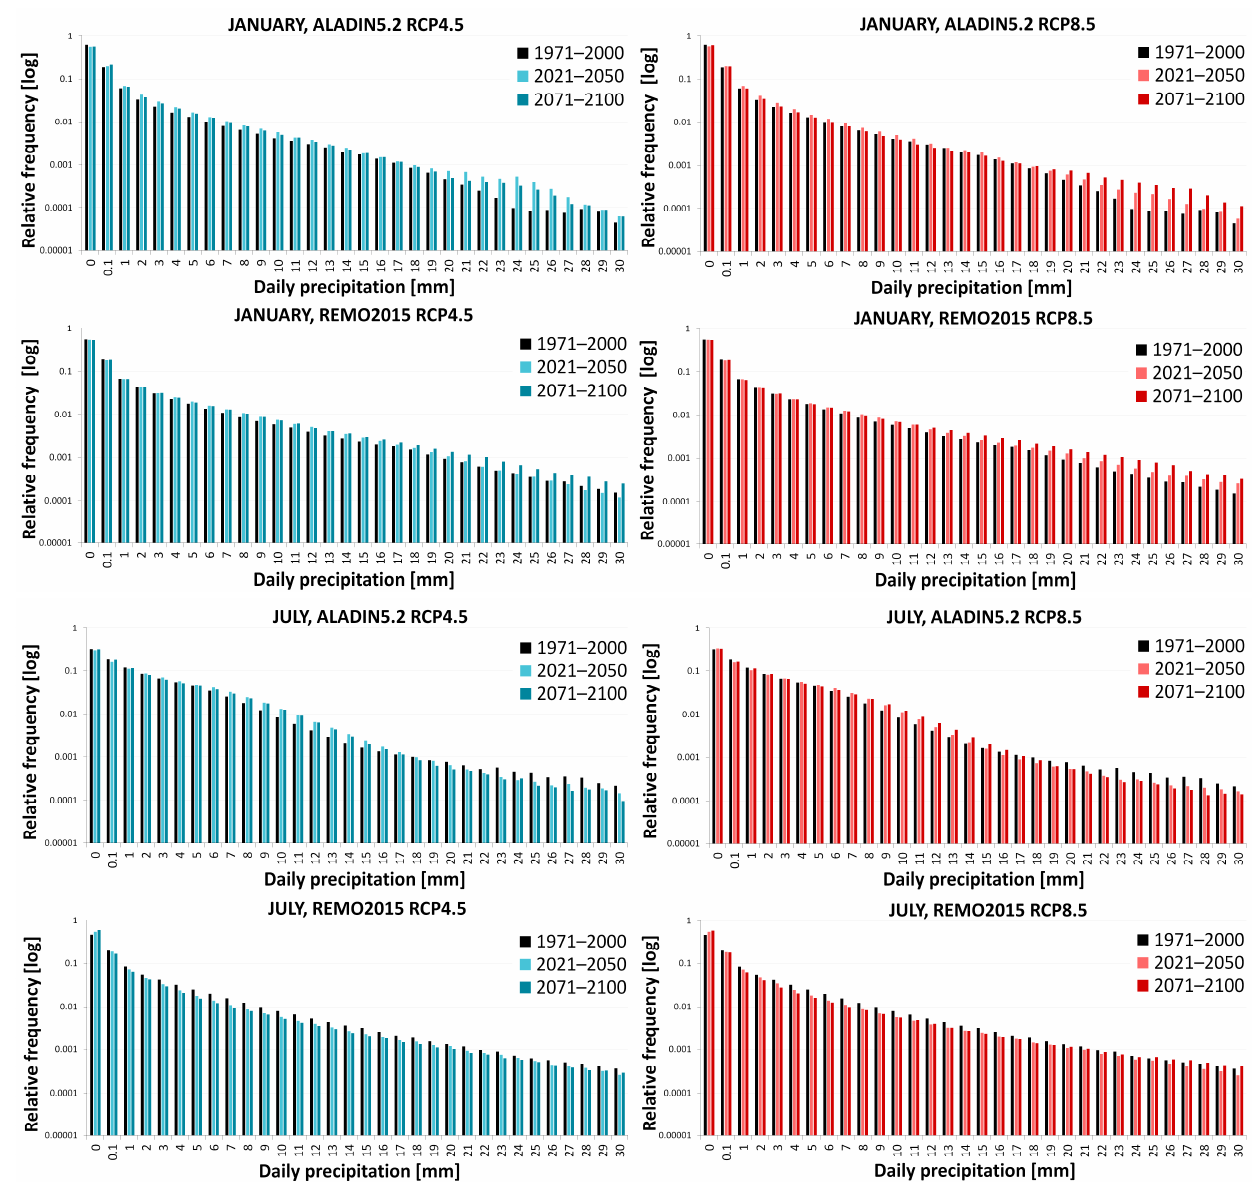
Figure 19. Relative frequency of mean daily amounts of precipitation over Hungary in January and July based on the ALADIN5.2 and REMO2015 simulations for 1971–2000, 2021–2050 and 2071–2100.